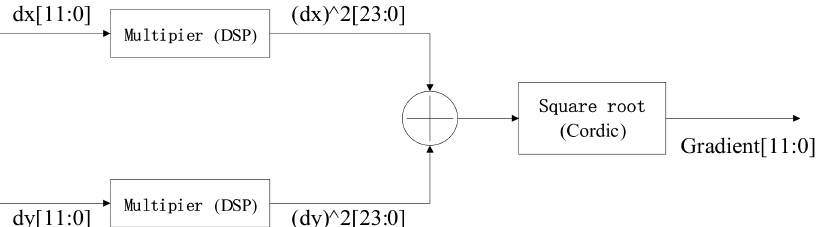
Figure 7. Gradient calculation method.